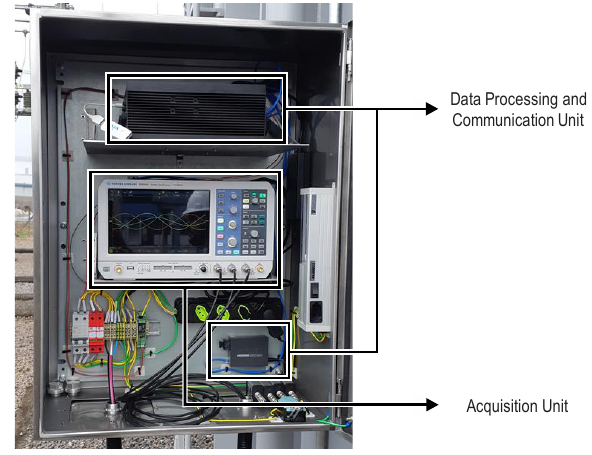
Figure 21. Internal components of the cabinet.